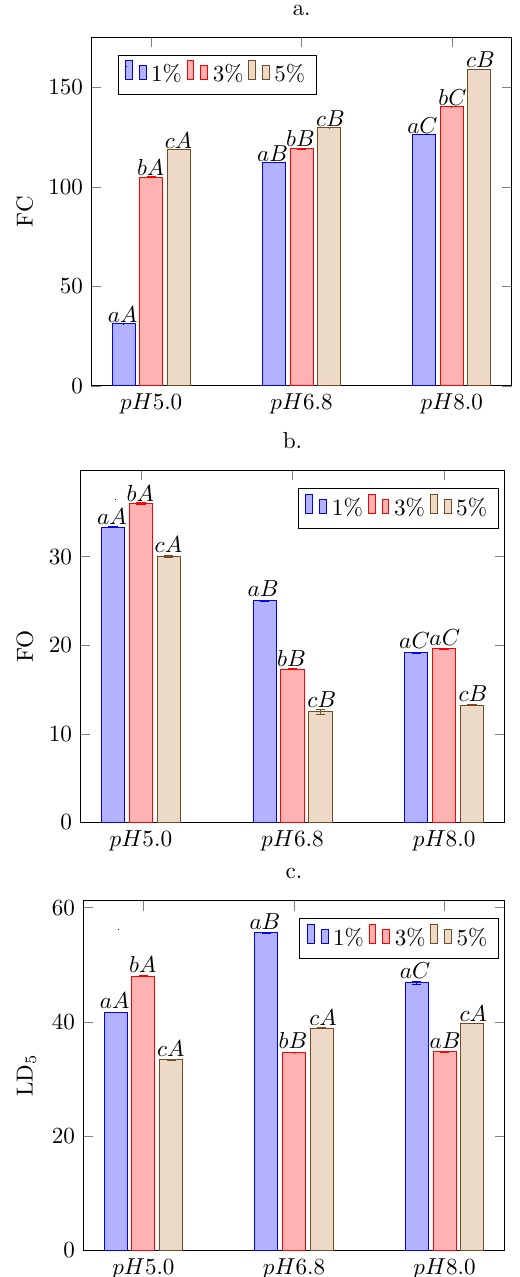
Figure 3. Foaming parameters of Vicia faba L. protein isolate solutions; ( a ) FC (foaming capacity), ( b ) FO (foam overrun), ( c ) LD 5 (liquid drainage). Small letters represent analysis in one pH for different protein isolate concentrations, big letters represent analysis of pH influence for selected isolate concentration (1%, 3%, and 5%). Different letters indicate statistically significant differences between the groups ( p < 0.05). Lowercase letters represent changes within one pH; capital letters represent changes of individual concentrations at the various